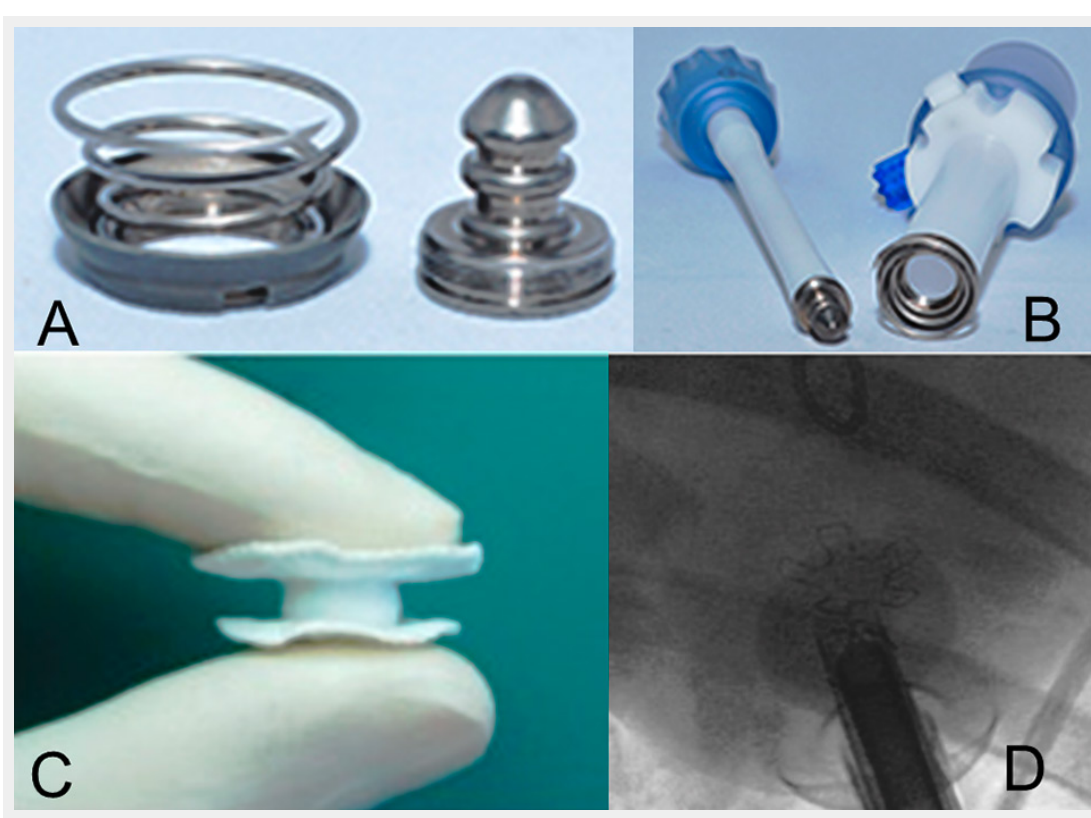
Figure 1 (A) and (B) The Apica TM access and closure device is composed of three parts: the introducer, the coil and the cap (Source: courtesy of Thoratec TM Corporation). (C) and (D) The CardiApex TM device is an apical plug allowing for full-percutaneous transapical valve procedures (Source: courtesy of Professor Hendrik Treede, University Heart Center Hamburg,